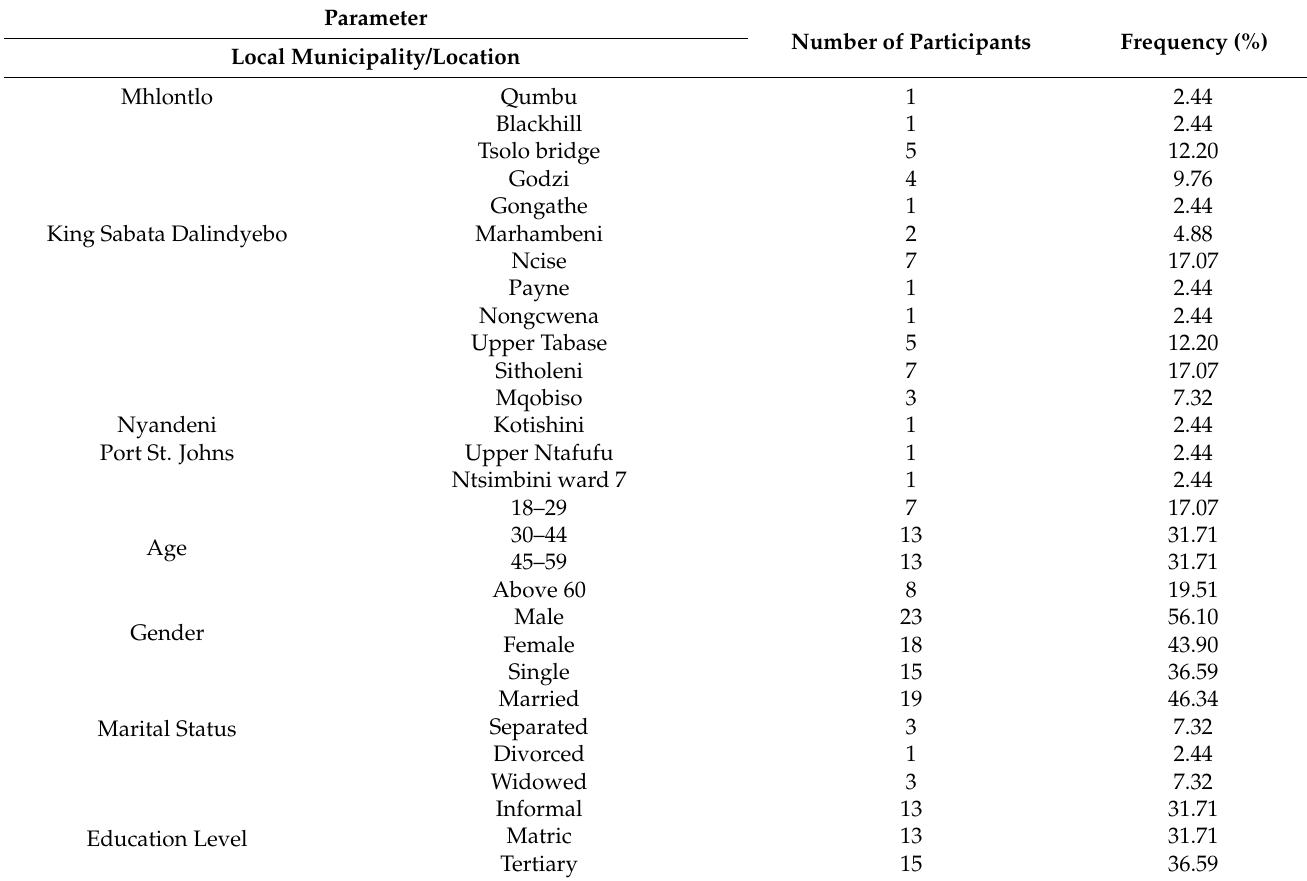
Table 1. Socio-demographic characteristics of the participants who use plants in mitigating cabbage and spinach diseases in OR Tambo Municipality, South Africa, (n =